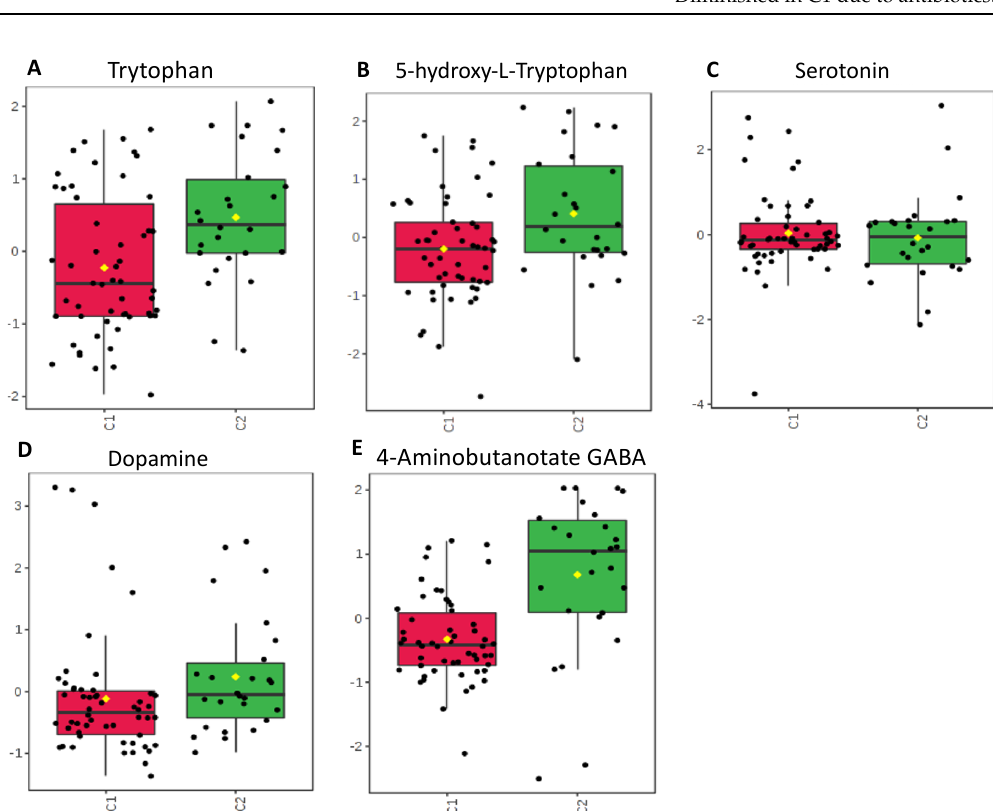
Figure 5. Neurotransmitters. Fecal concentrations compared between groups C1 and C2. ( A – D ) Neurotransmitters falling within the serotonin pathway: tryptophan ( p = 0.047), 5-HT ( p = 0.17), serotonin ( p = 0.82), dopamine ( p = 0.40). ( E ) GABA ( p = 0.001), a neurotransmitter which is produced in high quantities within enterocytes.